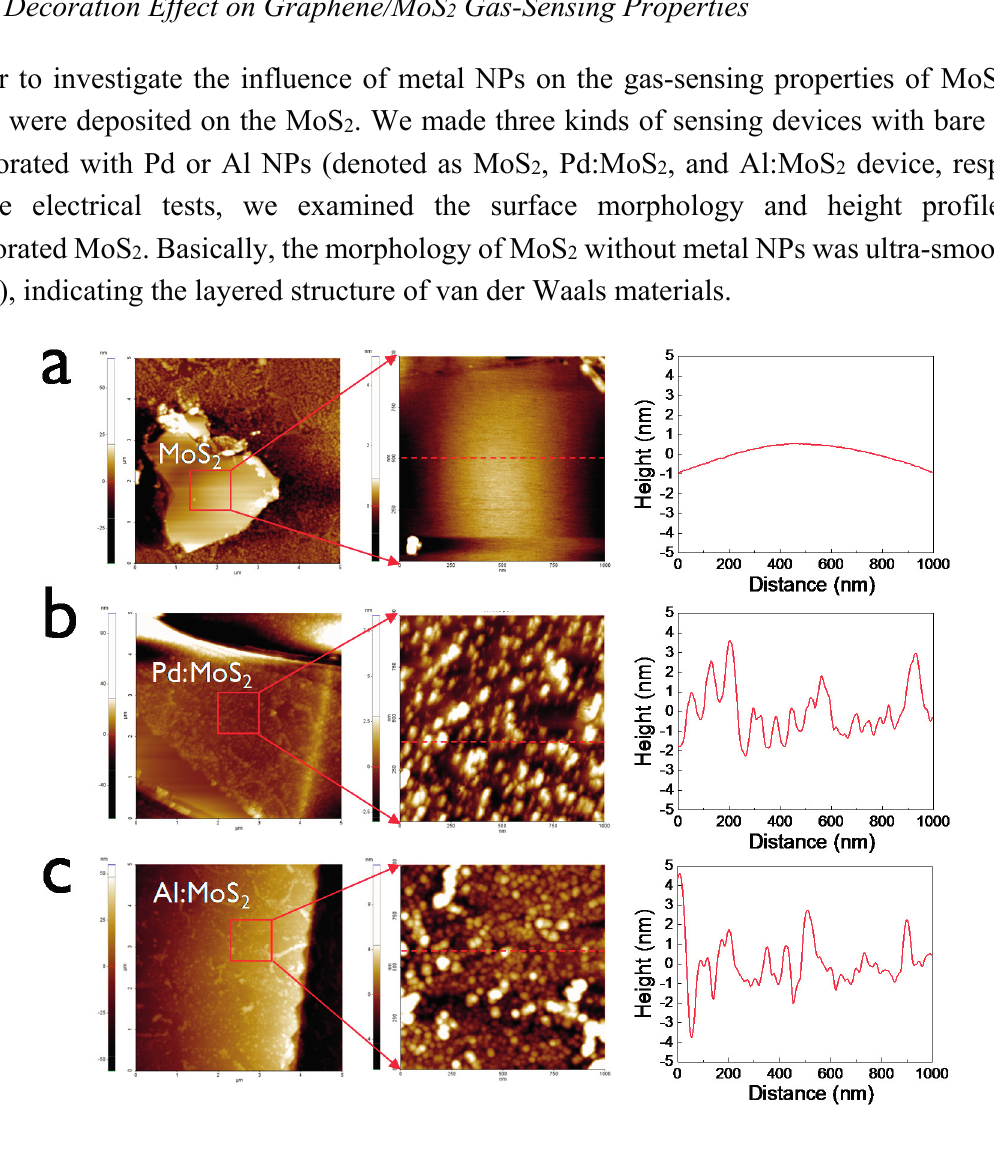
Figure 2. AFM morphology images and height profiles of ( a ) MoS 2 , ( b ) Pd:MoS 2 , and ( c ) Al:MoS 2 on Si/SiO 2